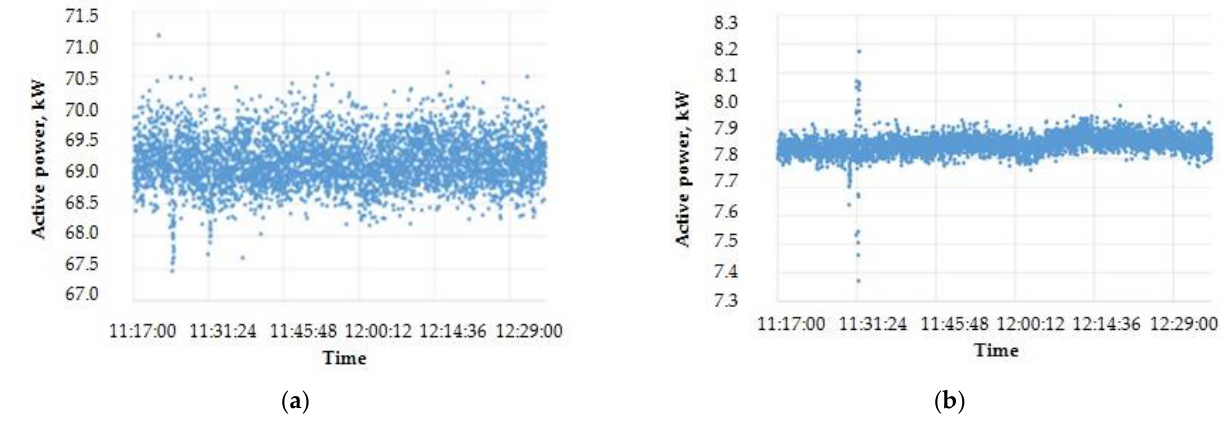
Figure 5. The active power curves of ( a ) exhaust fan of S428.CS dryer; ( b ) recirculation fan of S428.CS dryer.